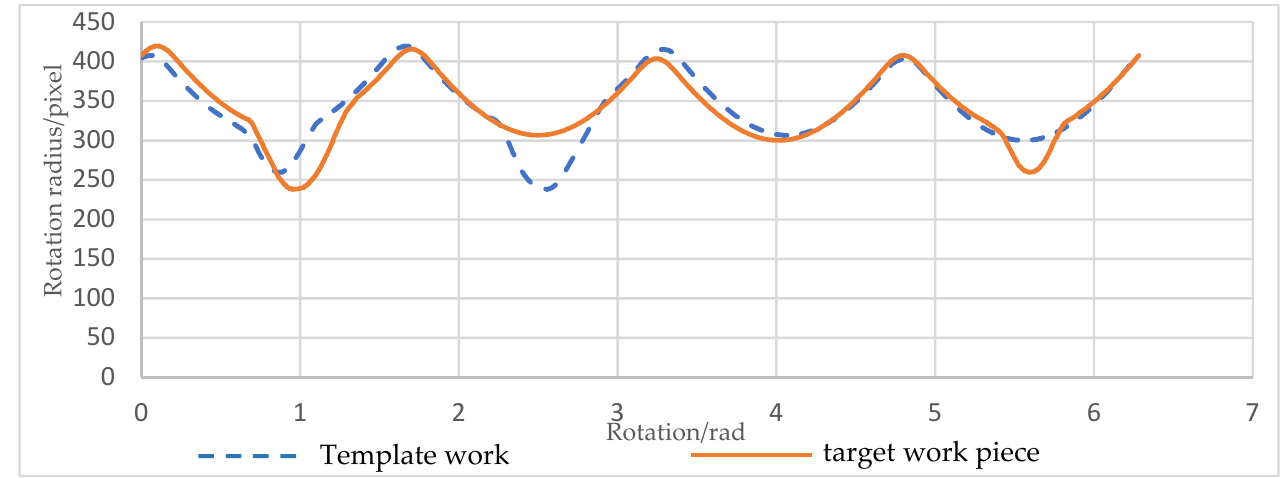
Figure 4. Periodogram comparison chart of the template workpiece and the target one. To sum up, the details about the algorithm of irregular workpiece template matching based on the contour phase difference are as follows: